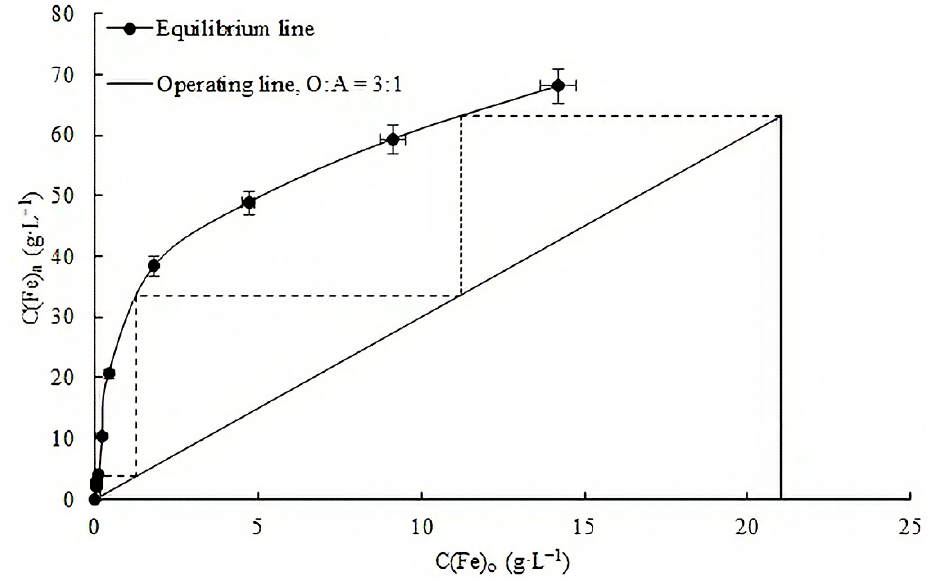
Figure 11. McCabe-Thiele plot for iron extraction. C(Fe 3+ ) a = 69.1 g·L − 1 , t = 20 °C, τ = 5 min. The conceptual flow sheet of hydrochloric acid slag leaching is shown in Figure 12.